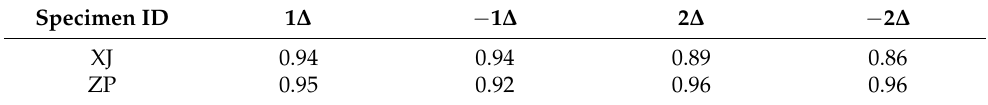
Table 4. Bearing capacity degradation coefficients of specimens XJ and ZP.